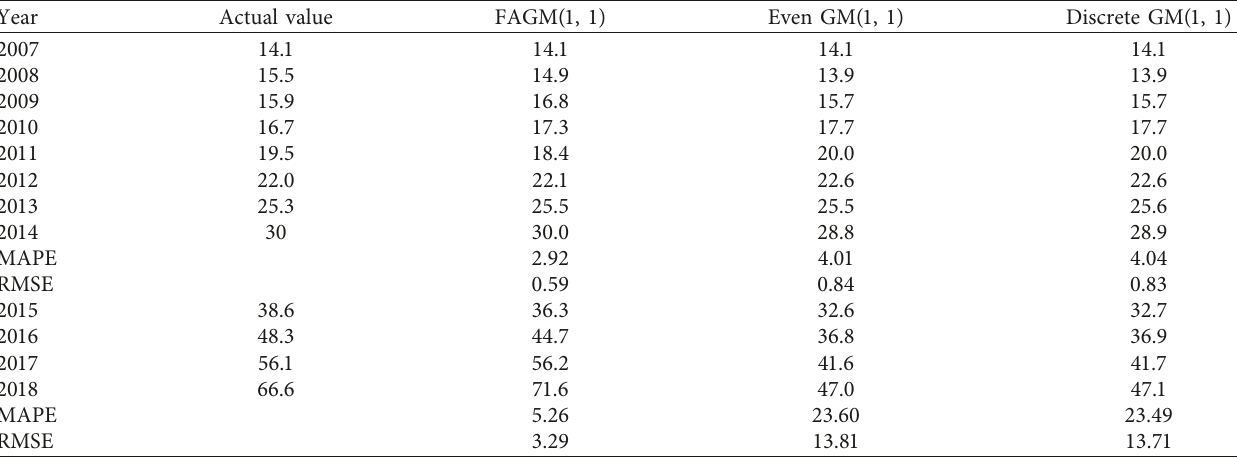
Table 2: The results of three models: Case